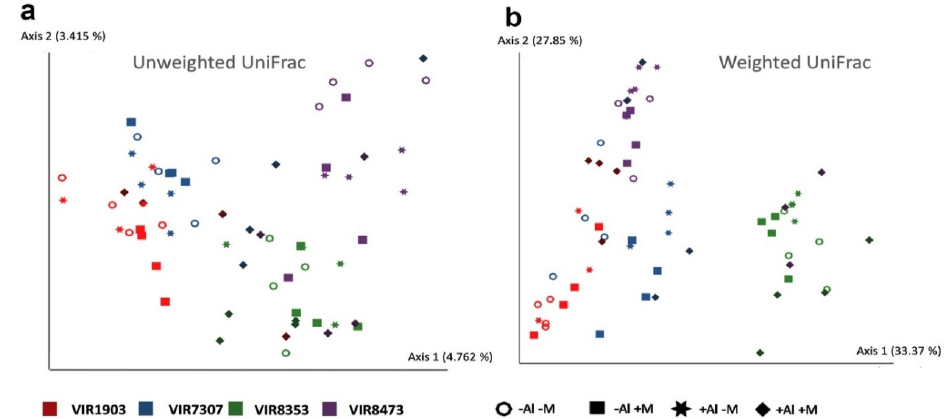
Figure 9. Beta-diversity plots evaluated by Unweighted ( a ) and Weighted ( b ) UniFrac for the rhizosphere prokaryotic microbiomes of pea genotypes VIR1903, VIR7307, VIR8353 and VIR8473 inoculated with microbial consortium. The parenthesized values are percent of variation described by each of axis. See details in the legend to Figure 1.